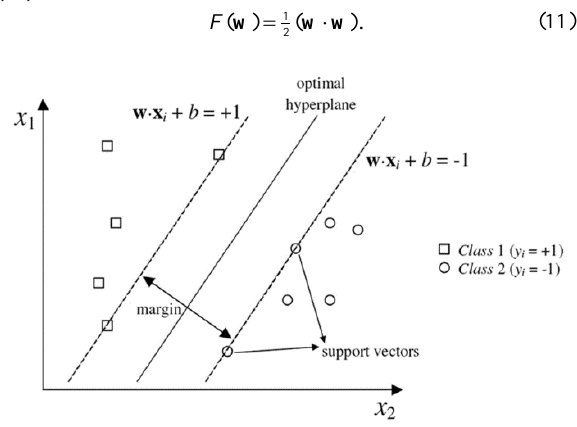
Figure 4: Tansig and logsig transfer functions.